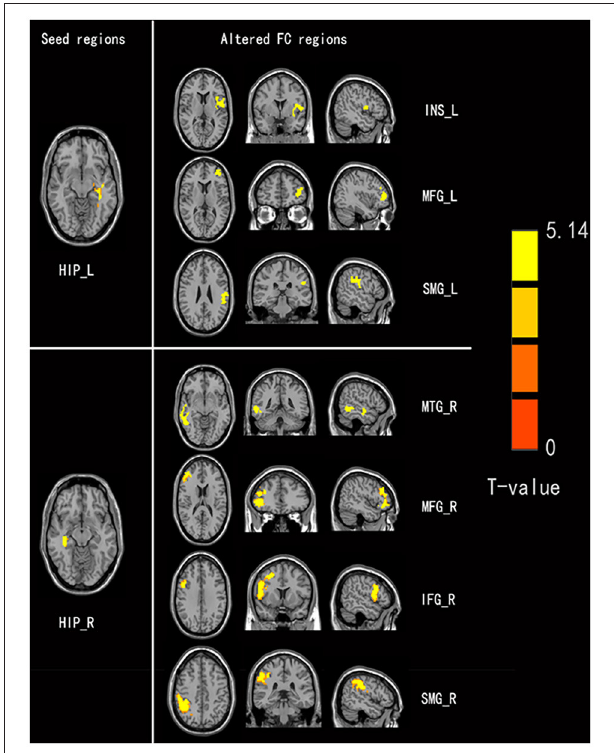
FIGURE 2 | Comparison of seed-based FC values between non-NPSLE patients and healthy controls (seed are left hippocampus and right hippocampus, respectively). Warm color’s regions represent brain areas with significantly increased FC values in non-NPSLE patients vs . that in healthy controls. Cluster-level FDR correction with a voxel threshold of p < 0.001 and cluster threshold of p < 0.05 (FC, Functional connectivity; HIP.L, Left hippocampus; INS.L, Left insula; MFGdor.L, Left dorsolateral middle frontal gyrus; SMG.L, Left supramarginal gyrus; HIP.R, Right hippocampus; MTG.R, Right middle temporal gyrus; MFGdor.R, Right dorsolateral middle frontal gyrus; IFGdor.R, Right dorsolateral inferior frontal gyrus; SMG.R, Right supramarginal